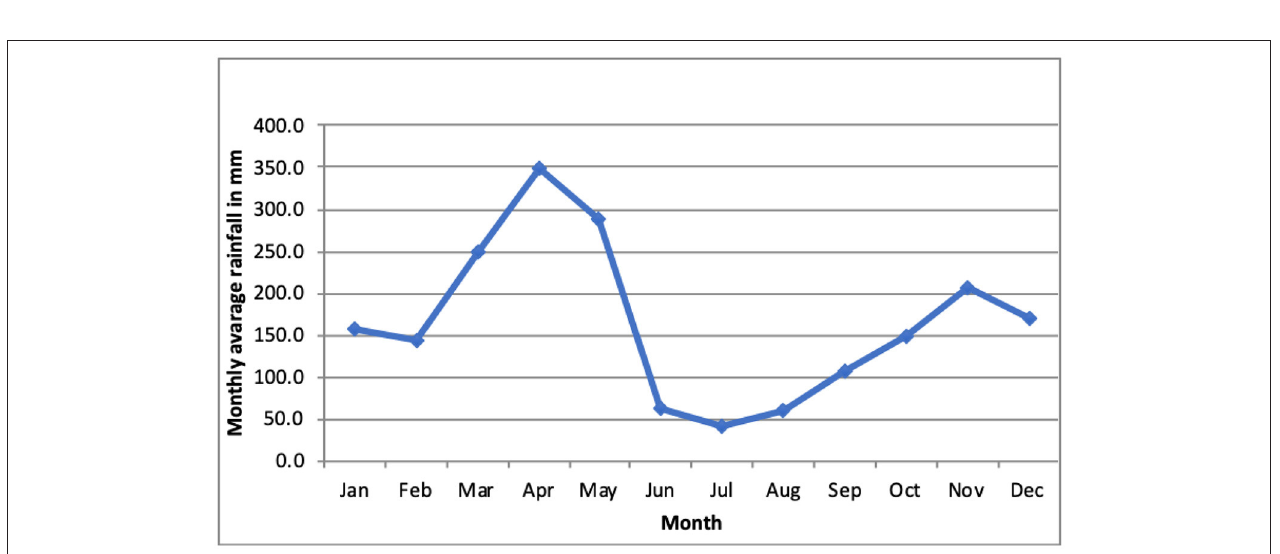
FIGURE 1 | The topographical map of the Lake Victoria region (A) adopted from Olaka et al. (2019) and (B) in the Kagera and Geita regions in the western parts of the Lake Victoria region of Tanzania.